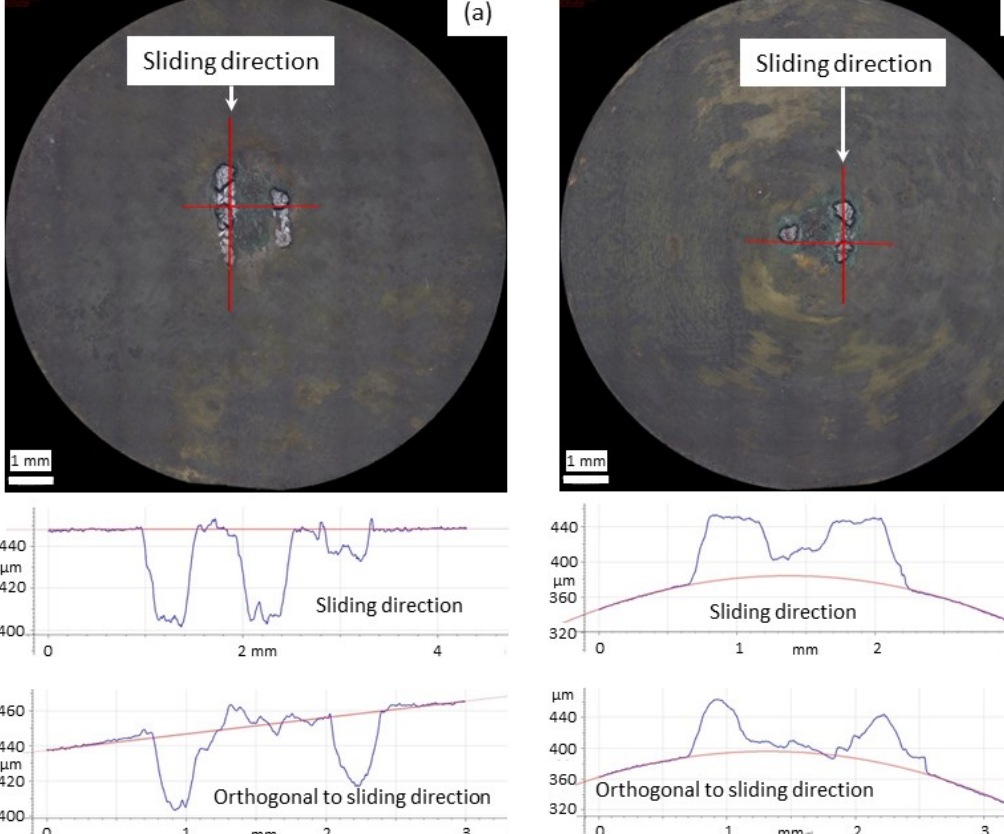
Figure 9. Volume growth on the pair 05 ( a ) flat; ( b ) sphere.